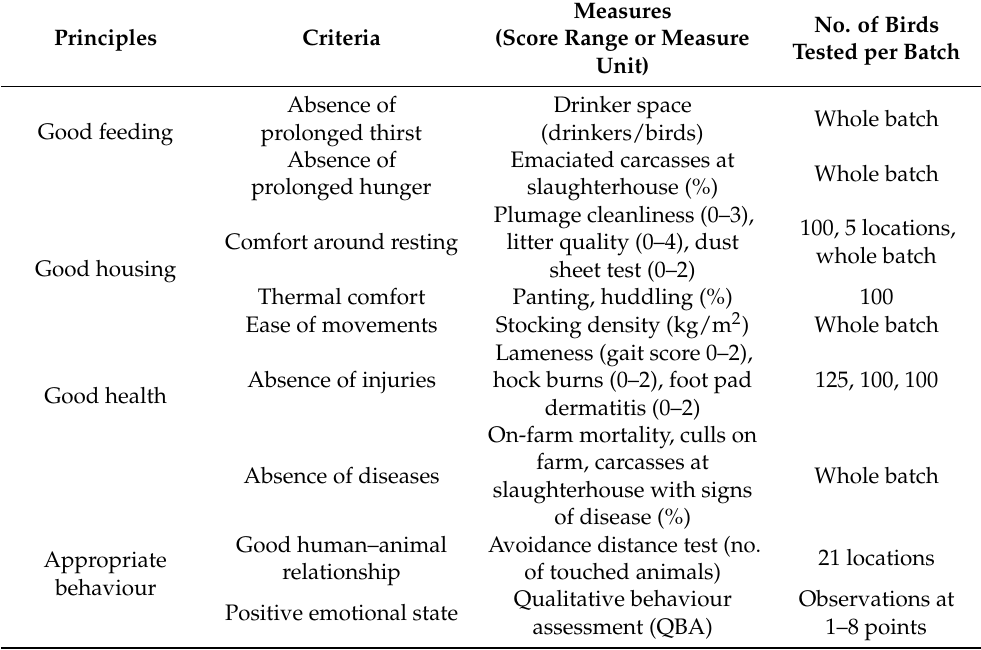
Table 1. List of the principles, criteria and measures that were assessed for animal welfare evaluation in each batch according to the Welfare Quality ® protocol for poultry